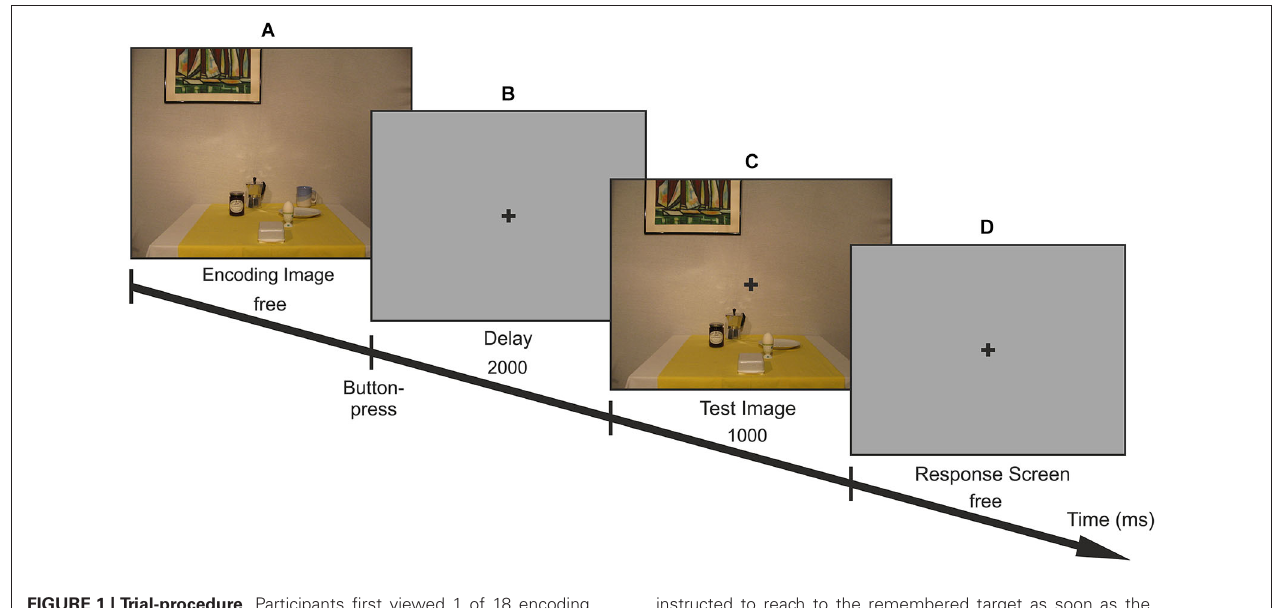
FIGURE 1 | Trial-procedure . Participants first viewed 1 of 18 encoding images (A) without time limit and free gaze. After a 2 s blank gray screen (B) the test image appeared for 1 s (C) in which one of the objects on the table was missing (= target; here: cup). They were